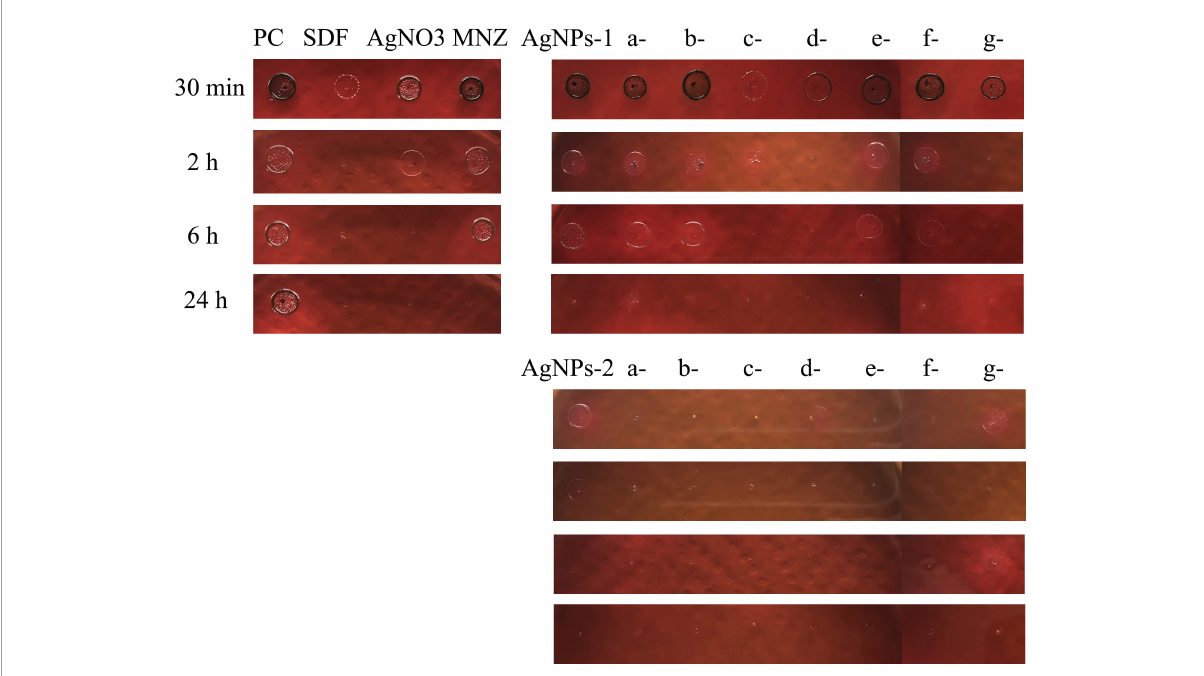
FIGURE4 Summary for the time-dependent antibacterial effect of AgNPs-1/2 and P-AgNPs-1/2 on P. gingivalis suspensions. a, b, c, d, e, f, and g are PEG 400, PEG 2000, PEG-SH 5000, PVP (MW 10000), Pluronic P103 (Mn 5000), P123 (Mn 5800), and F127 (Mn 12000), respectively. SDF, silver diamine fluoride; MNZ,